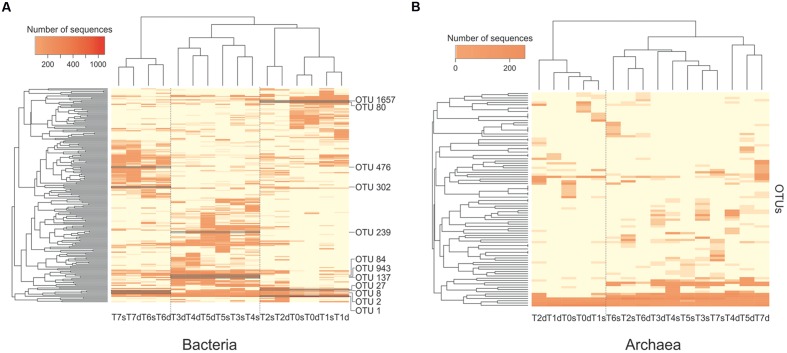
Hierarchical clustering of the composition of the bacterial
(A) and archaeal (B) communities based on 16S rRNA transcripts sampled along the course of the experiment (T0–T7) from the surface (s) and deep (d) layers of the sediment. The heatmap shows the relative abundance of each operational taxonomic unit (OTU) (rows). The names of the bacterial OTUs that were found to characterize each of the three main clusters of samples (column) are indicated.